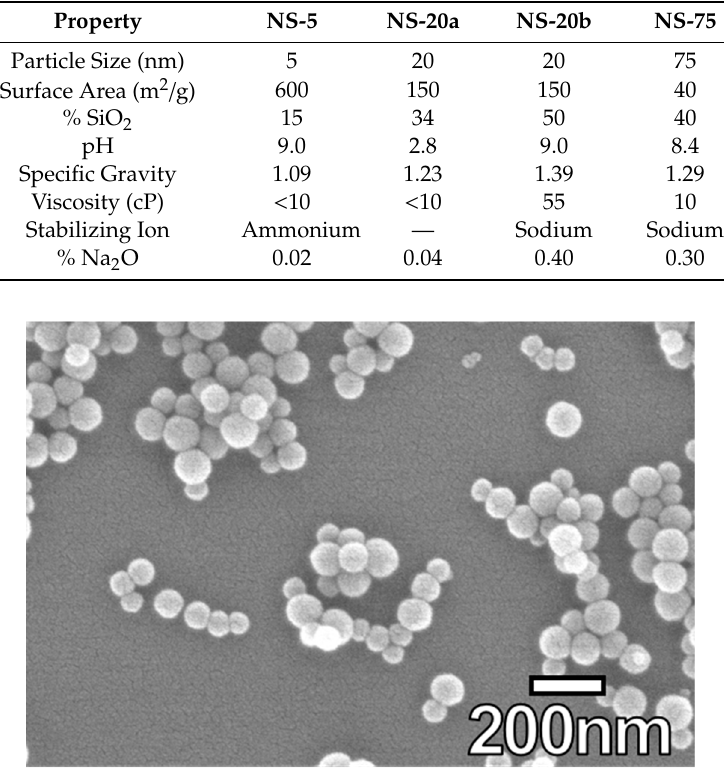
Figure 2. Scanning electron microscopy (SEM) image of NS-75.